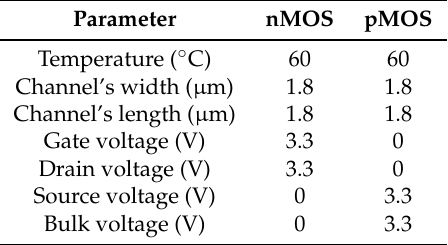
Table 1. Physical, thermal, and electrical conditions of the tested nMOS and pMOS devices.